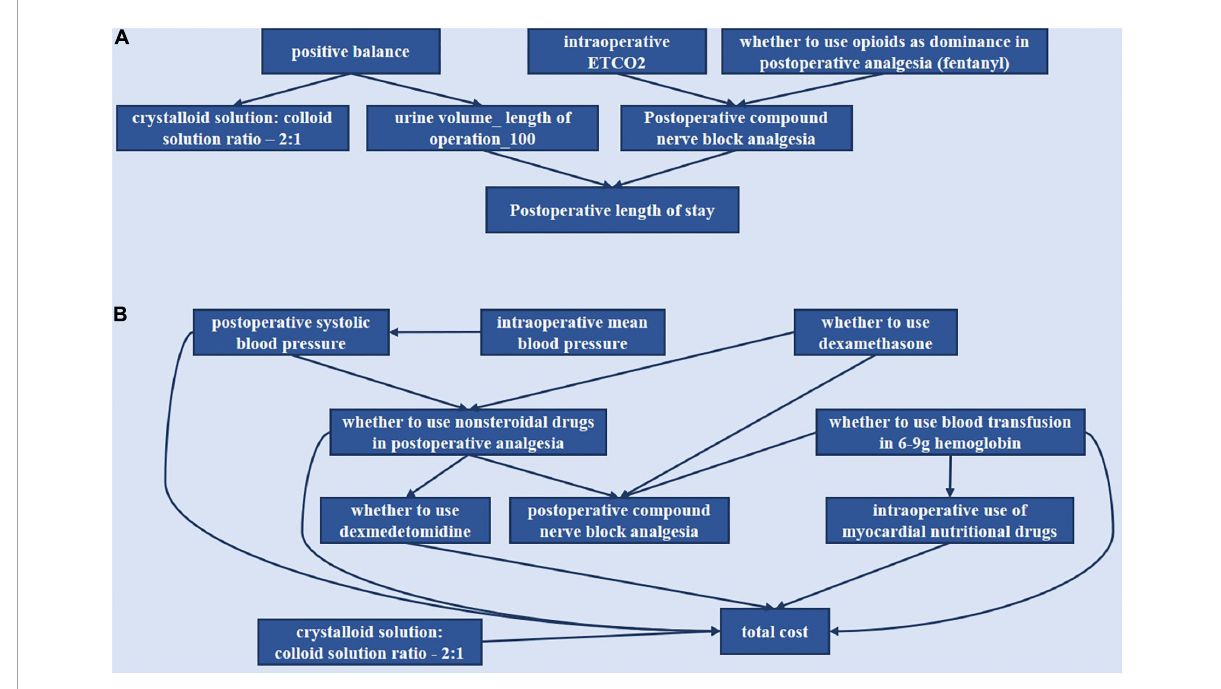
FIGURE5 Bayesian causal network of various indicators of the postoperative length of stay and total cost. (A) Postoperative length of stay. (B) Total